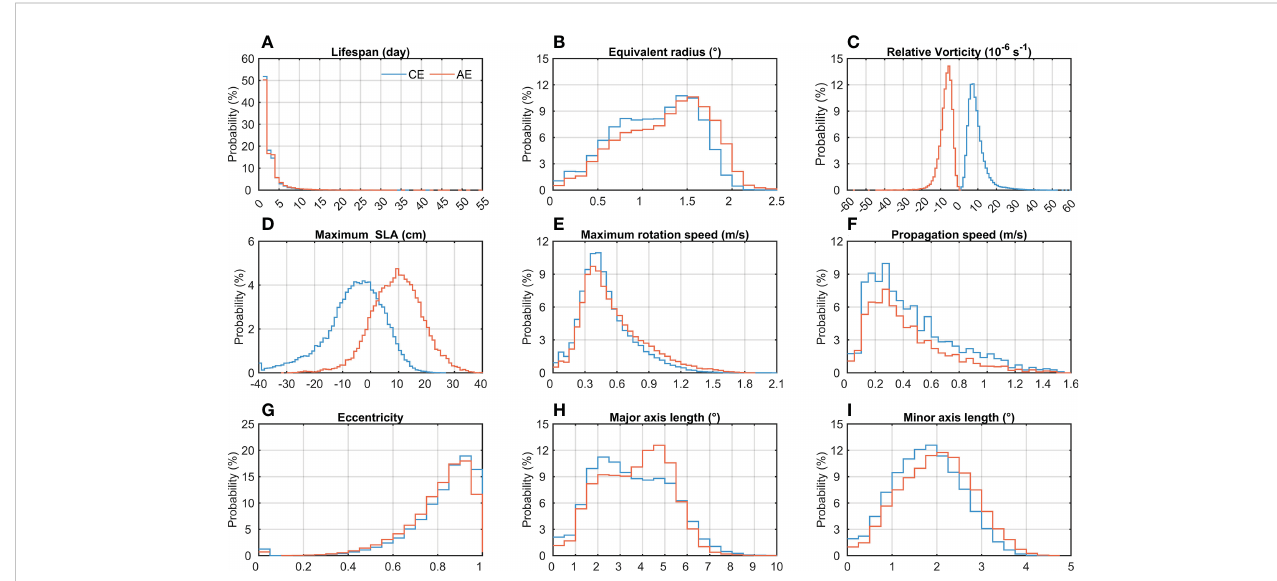
FIGURE 2 Basic features of the MEs in the core of the western Paci fi c warm pool (WPWP). The blue and red lines represent CE and AE in (A – I) . The variables in (D, E) are maximum values within the region of the detected MEs, and the relative vorticity (C) is the value at the centers of MEs. The variables shown in (B, G – I) are corresponding variables of an ellipse with the same standard second order central moment as the region of an eddy, i.e. the equivalent radius, eccentricity, major axis length, and minor axis length of the